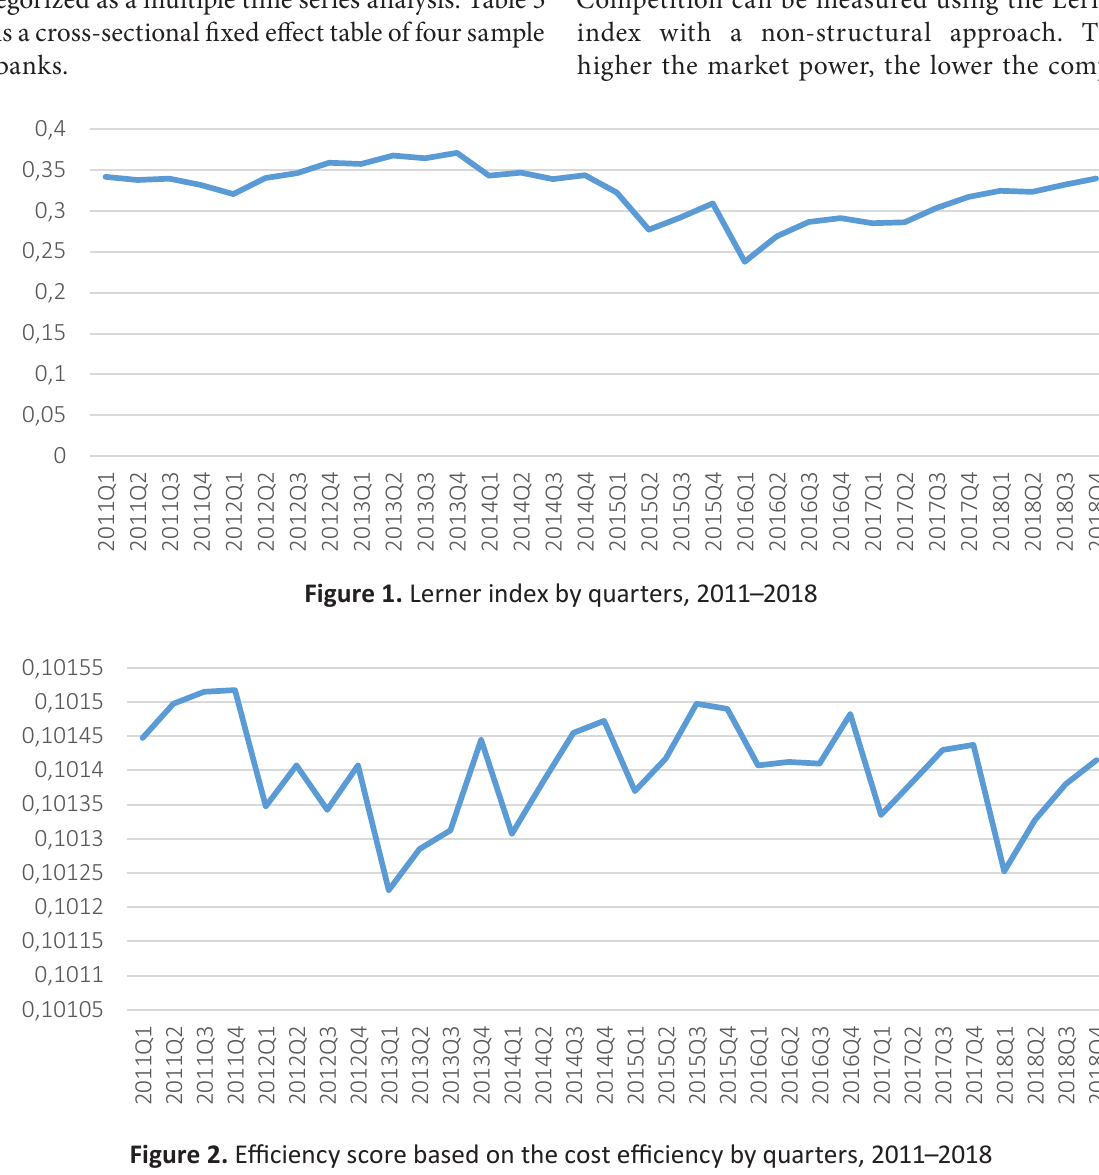
Figure 2. Efficiency score based on the cost efficiency by quarters,